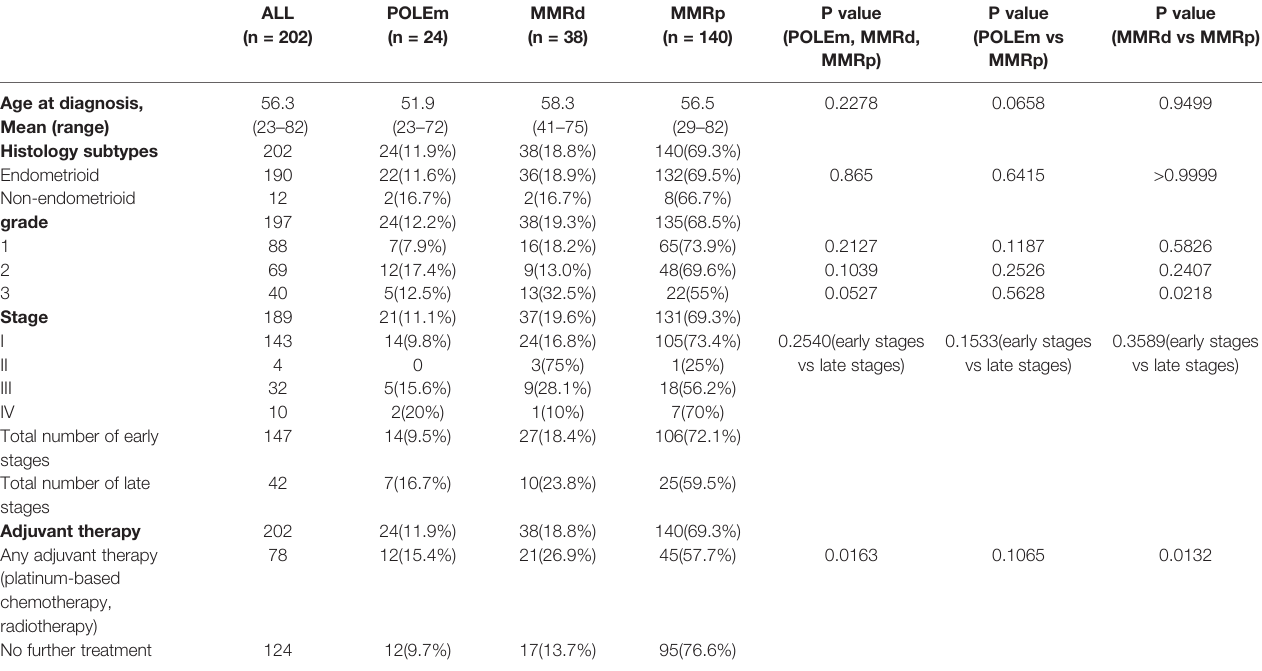
TABLE 1 | Clinicopathological characteristics of endometrial cancers regarding POLE and MMR status. One-way ANOVA, Unpaired t test, Chi-square test and Fisher ’ s Exact test were used and p<0.05 was considered as statistical signi fi cance. ALL POLEm (n = 202) (n =